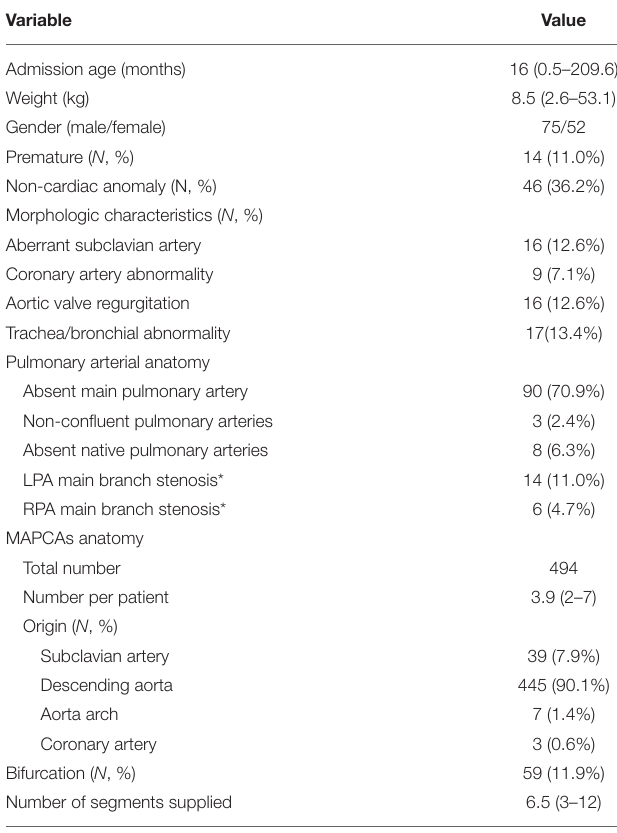
TABLE 1 | Patient characteristics at the initial admission ( n =